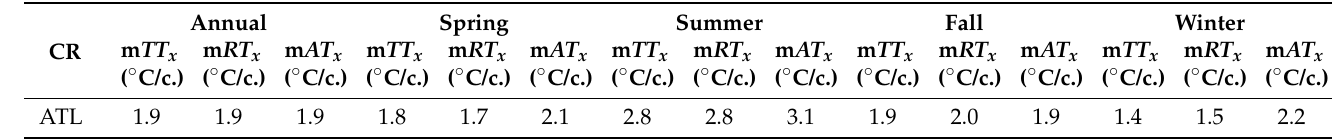
Table 9. Regional temperature maxima slopes reported in degrees Celsius per century ( ◦ C/c.) “m” represents “slope”. m TT x —Slope of Total Temperature Maximum, m RT x —Slope of Ra- diative Temperature Maximum, and m AT x —Slope of Advective Temperature Maximum. “CR” represents “climate region”. ATL—Atlantic Canada, GRL—Great Lakes/St. Lawrence